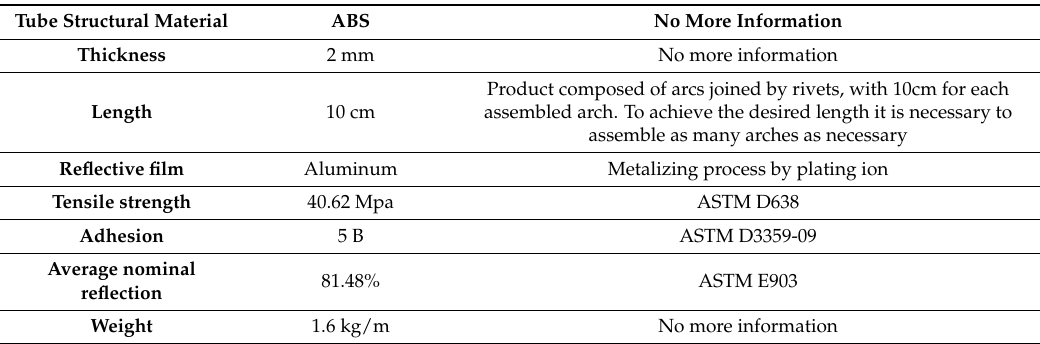
Table 5. Technical characteristics of the developed